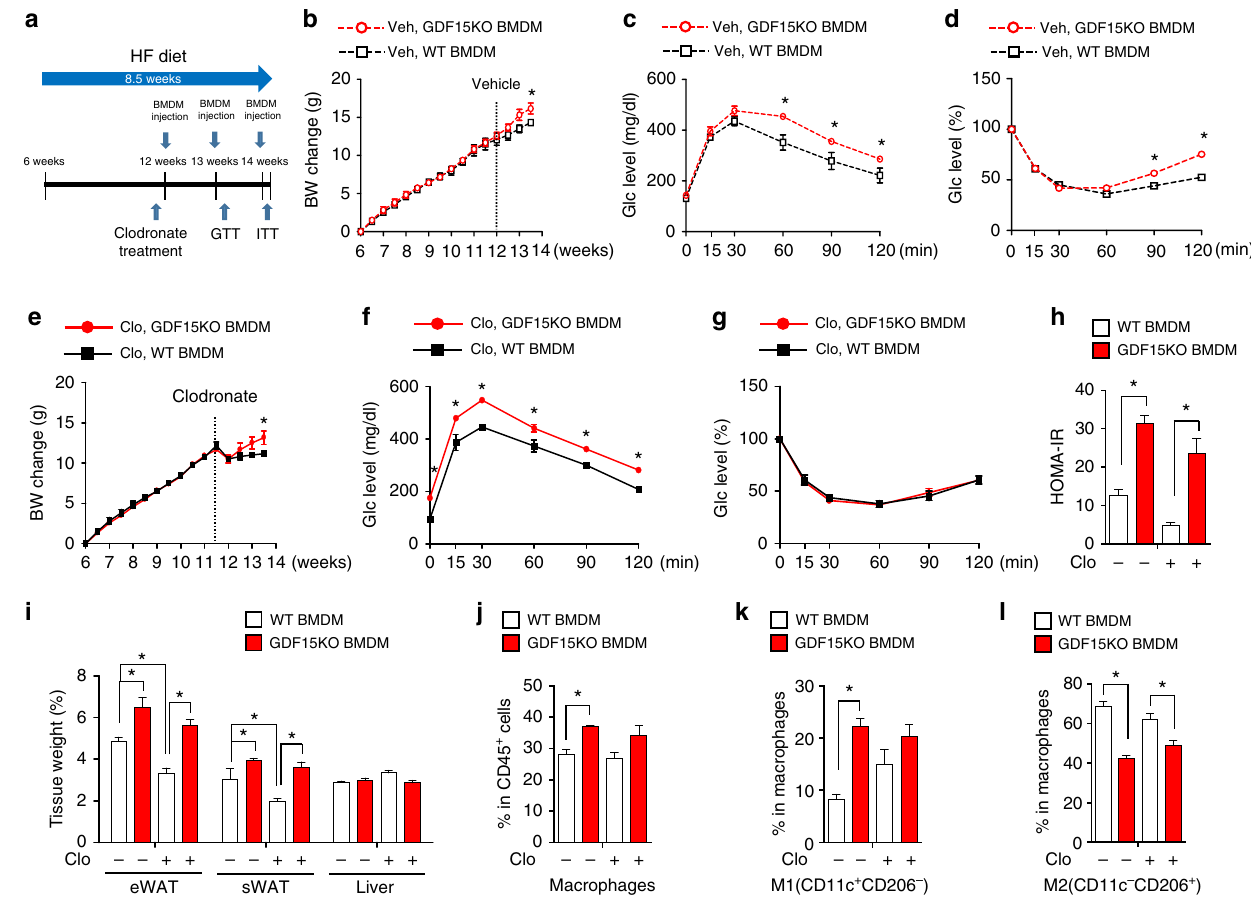
Fig. 5 Adoptive transfer of GDF15KO macrophages aggravates glucose tolerance. a Diagram representing the experimental design. b Body weight change of PBS-liposome-treated HFD-fed mice intravenously injected with BMDMs from WT or Gdf15 -KO ( n = 5 per group). c , d IPGTT after a 16 h fast and an ITT after a 4 h fast ( n = 5 per group). e Body weight change of clodronate liposome – treated HFD-fed mice injected with BMDMs from WT or Gdf15 -KO ( n = 5 per group). f , g IPGTT after a 16 h fast and ITT after a 4 h fast ( n = 5 per group). h HOMA-IR of PBS or clodronate liposome-treated HFD-fed mice injected with BMDMs from WT or Gdf15 -KO ( n = 5 per group). i Tissue weight of PBS or clodronate liposome-treated HFD-fed mice injected with BMDM from WT or Gdf15 -KO ( n = 5 per group). j – l FACS analysis of total macrophages (CD45 + /F4/80 + /CD11b + ) and M1 (CD11c + /CD206 - ) and M2 (CD11c − /CD206 + ) macrophages in fi ltrated into the eWAT. Data represent means ± SEM and are representative of three independent experiments. * p < 0.05 (two-tailed Student ’ s t